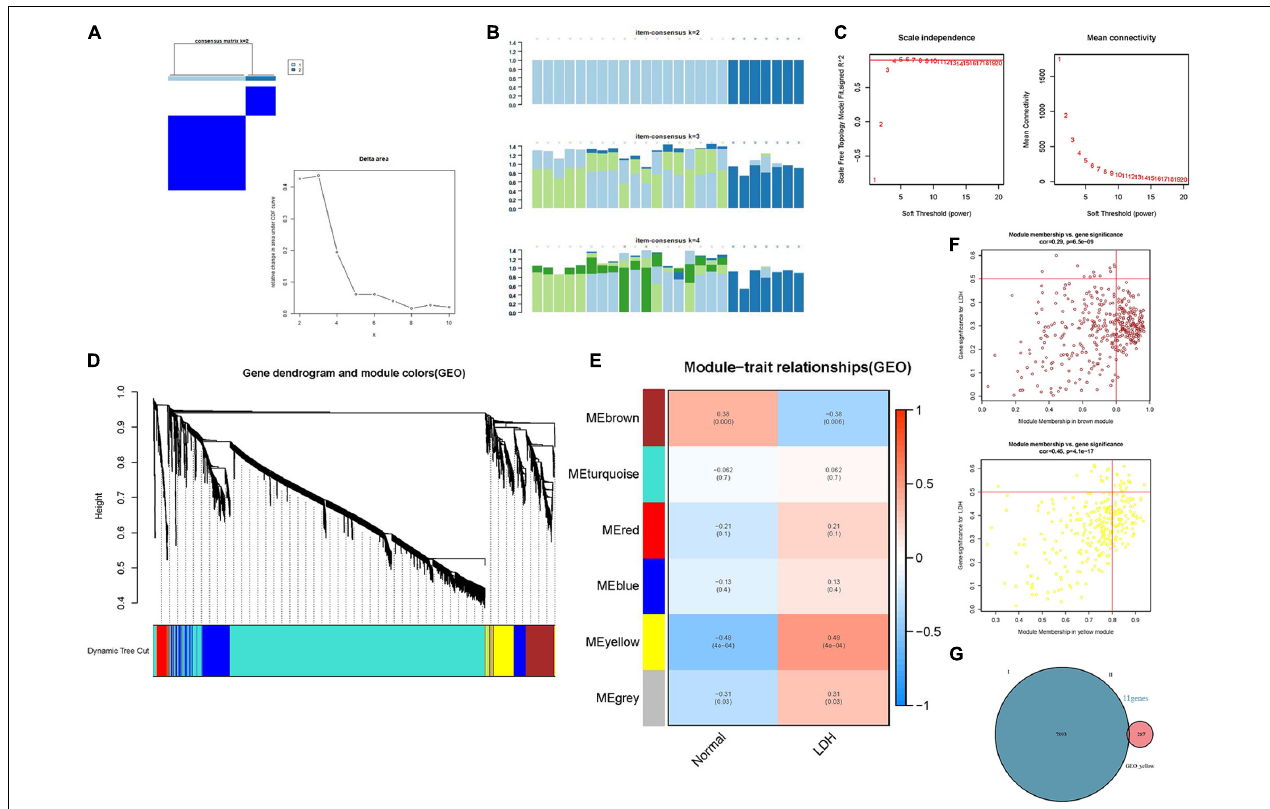
FIGURE 5 | Identification of the hub genes in LDH. (A) Consensus clustering matrix for k = 2 in LDH dataset [Consensus clustering cumulative distribution function (CDF) for k = 2 to 9]; (B) Consensus clustering matrix (Each bar represents a grid, where the more complete the bar color, the better the clustering degree); (C) β = 4 (scale free R 2 = 0.9) was chosen to construct a scale-free network; (D) A cluster tree of co-representation network modules based on 1-Tom matrix is constructed. (E) Module-trait relationships, where different colors represent different modules in two groups (each row corresponds to a module, and each unit includes a correlation coefficient and a p -value). (F) Module-gene relationships: each plot includes a correlation coefficient and a p -value. (G) Venn plot: identification of intersection genes between cluster genes and module